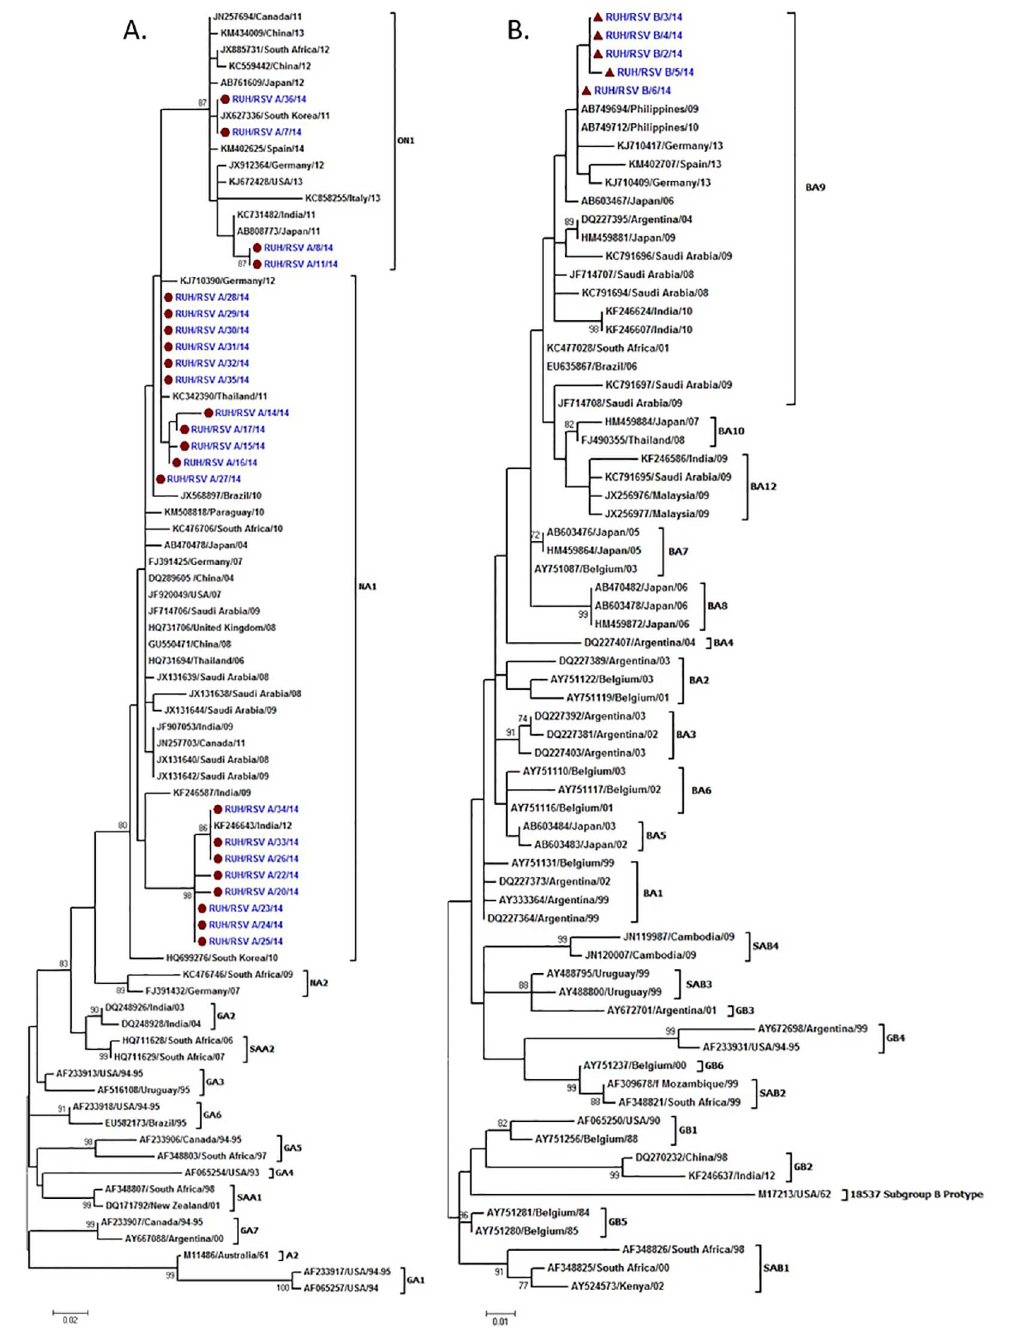
Fig 1. Phylogenetic trees for hRSV group A (A) and group B (B). The nucleotidesequencesfrom the second variableregionof the G protein gene of the study RSVA strains are indicatedby solid circles and RSVB by solid triangles. The nucleotidesequenceswere alignedwith the CLUSTAL W program, and phylogenetic trees were constructed by Maximum Likelihood method using MEGA6 software. Bootstrap values greater than 70% are shown at the branch